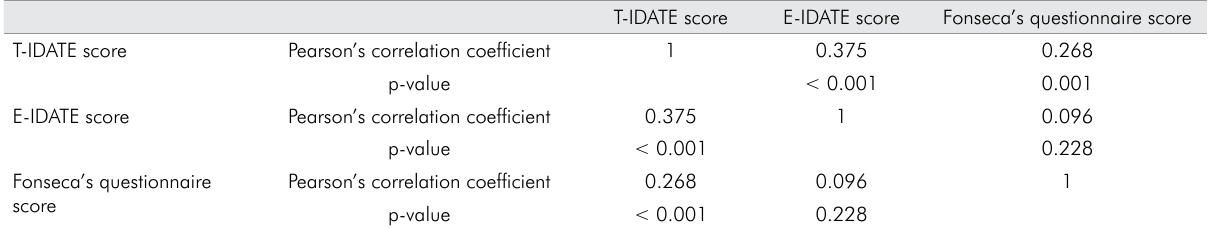
Table1. Correlations between TMD severity (Fonseca’s questionnaire score), state anxiety (E-IDATE score), and trait anxiety (T-IDATE score).